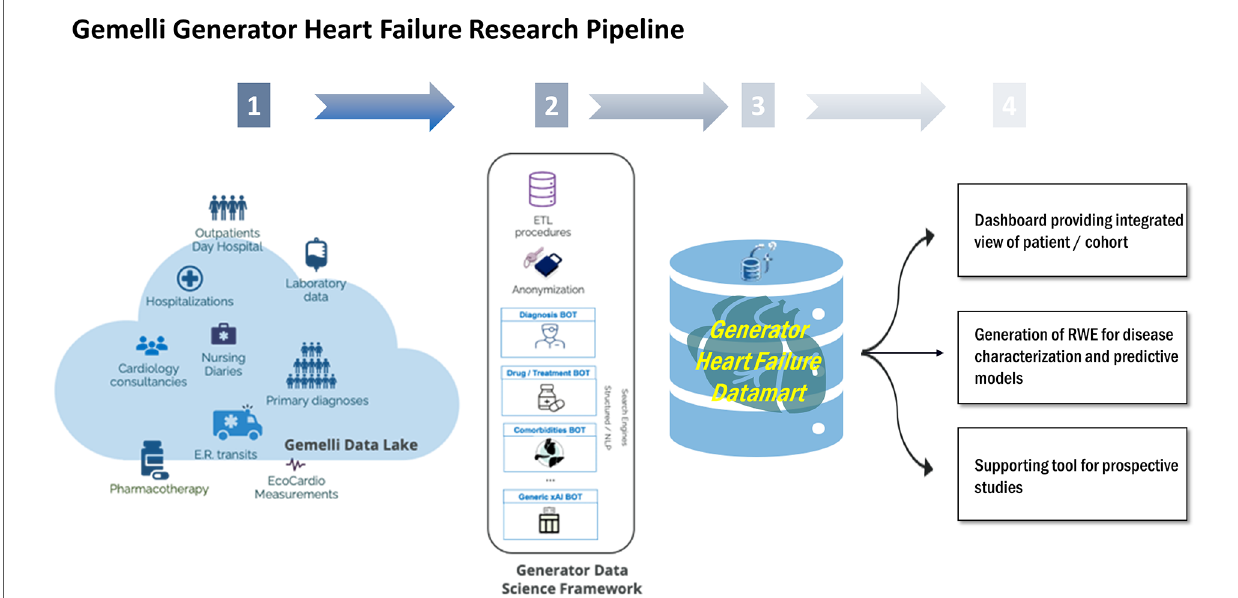
FIGURE 1 Overview of HF daily-updated analysis framework. ETL, Extract, Transform, Load; ER, Emergency Room; NLP, Neural Language Processing; RWE, Real World Evidence; xAI, eXplainable Arti fi cial